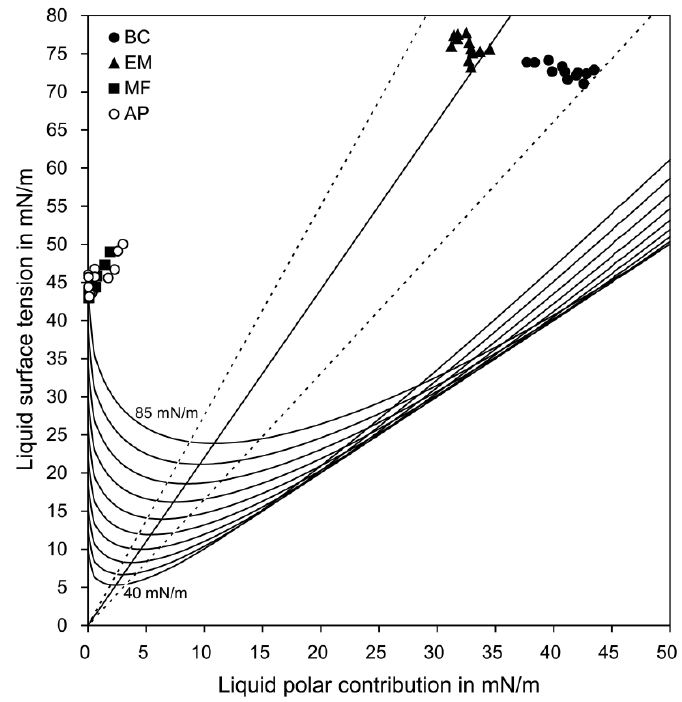
Figure 3. Diagram of the isograms corresponding to work of 40, 45, 50, 55, 60, 65, 70, 75, 80, and 85 mN/m, showing each data point ( σ ( σ p )) of the four sealers. The two dotted lines indicate a range of acceptable performance (± 25% of the optimum line in this study). Table 3. Wetting and adhesion properties of the four sealers, derived from the wetting envelope and isogram diagram, respectively ( n = 12).